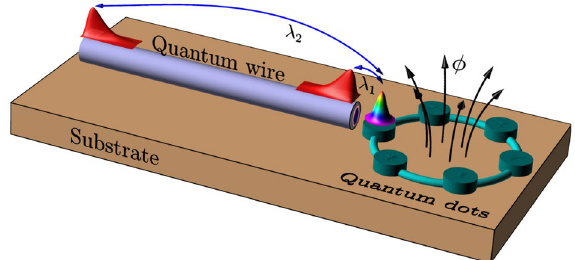
Figure 1. ( a ) Schematic representation of the system under study. A nanowire driven into a superconducting regime supports a MZM at each edge and influences the persistent currents of a quantum ring, threaded by a magnetic flux. ( b ) The quantum ring consists of an array of quantum dots uniformly distributed on a circumference. The MZMs are assumed to be coupled to the same quantum dot of the ring, with coupling constants (cid:31) 1 and (cid:31) 2